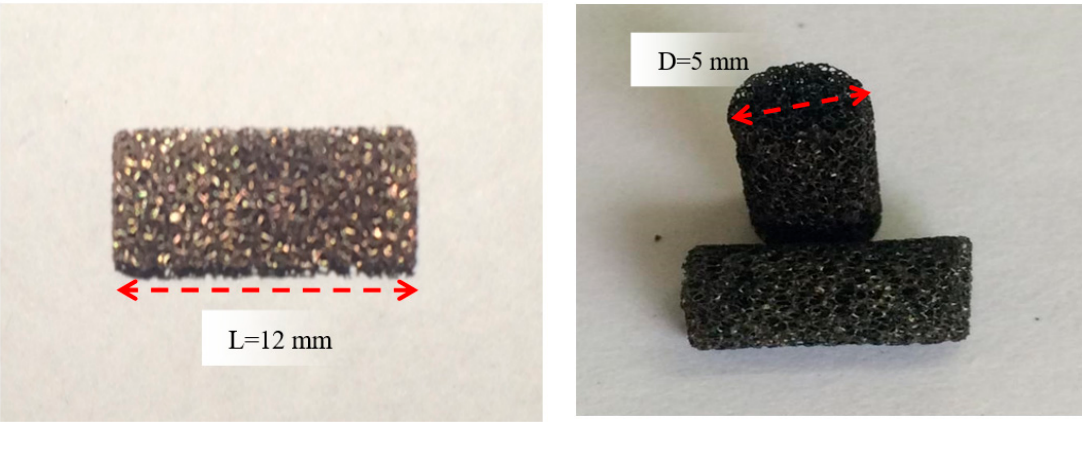
Figure 1. Photographs of ( a ) substrate and ( b ) catalysts.